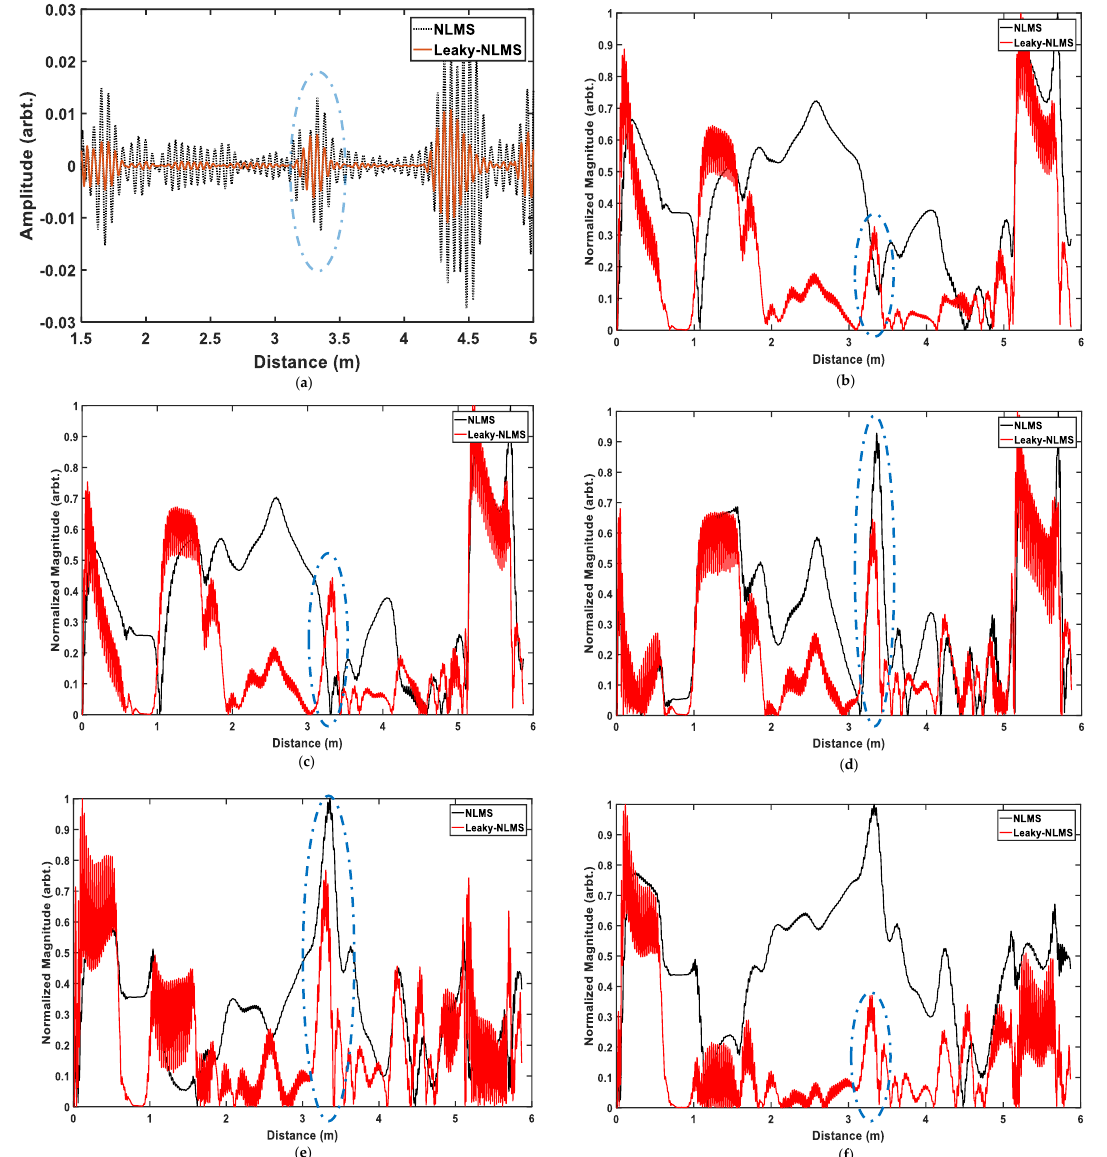
Figure 13. Comparison of the result achieved from NLMS (black) vs leaky LMS (orange) where ( a ) shows the time-domain results and ( b – f ) show the normalized magnitudes of filter order 1 to 5, respectively.